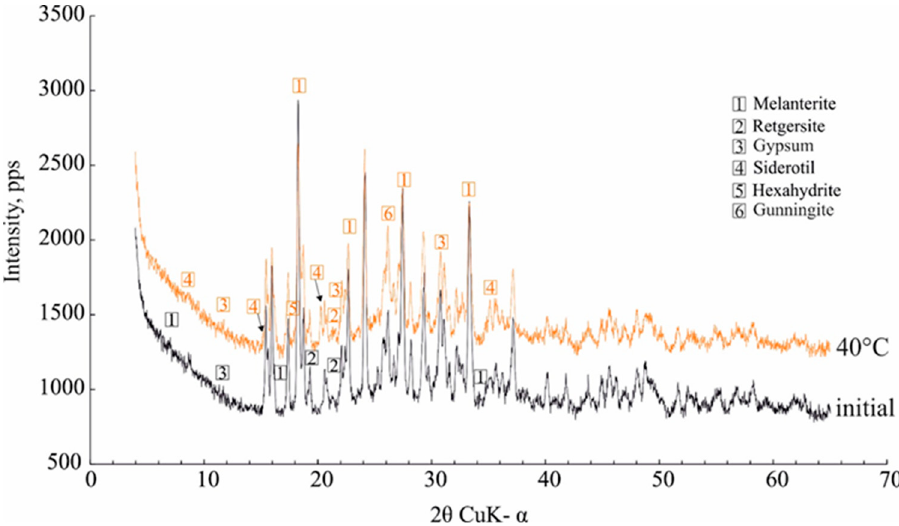
Figure 6. The effect of heating at 40 °C on the melanterite XRD characteristics. Figure 6. The e ff ect of heating at 40 ◦ C on the melanterite XRD